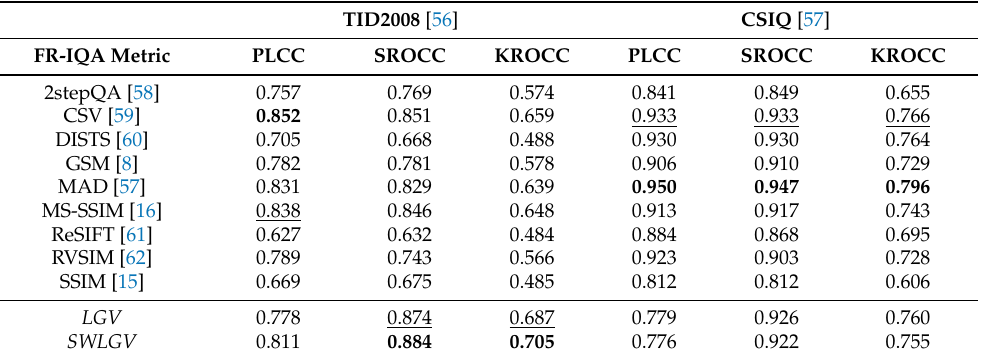
Table 3. Comparison of LGV and SWLGV to the state-of-the-art on TID2008 [56] and CSIQ [57]. The highest values are typed in bold , while the second highest ones are underlined.